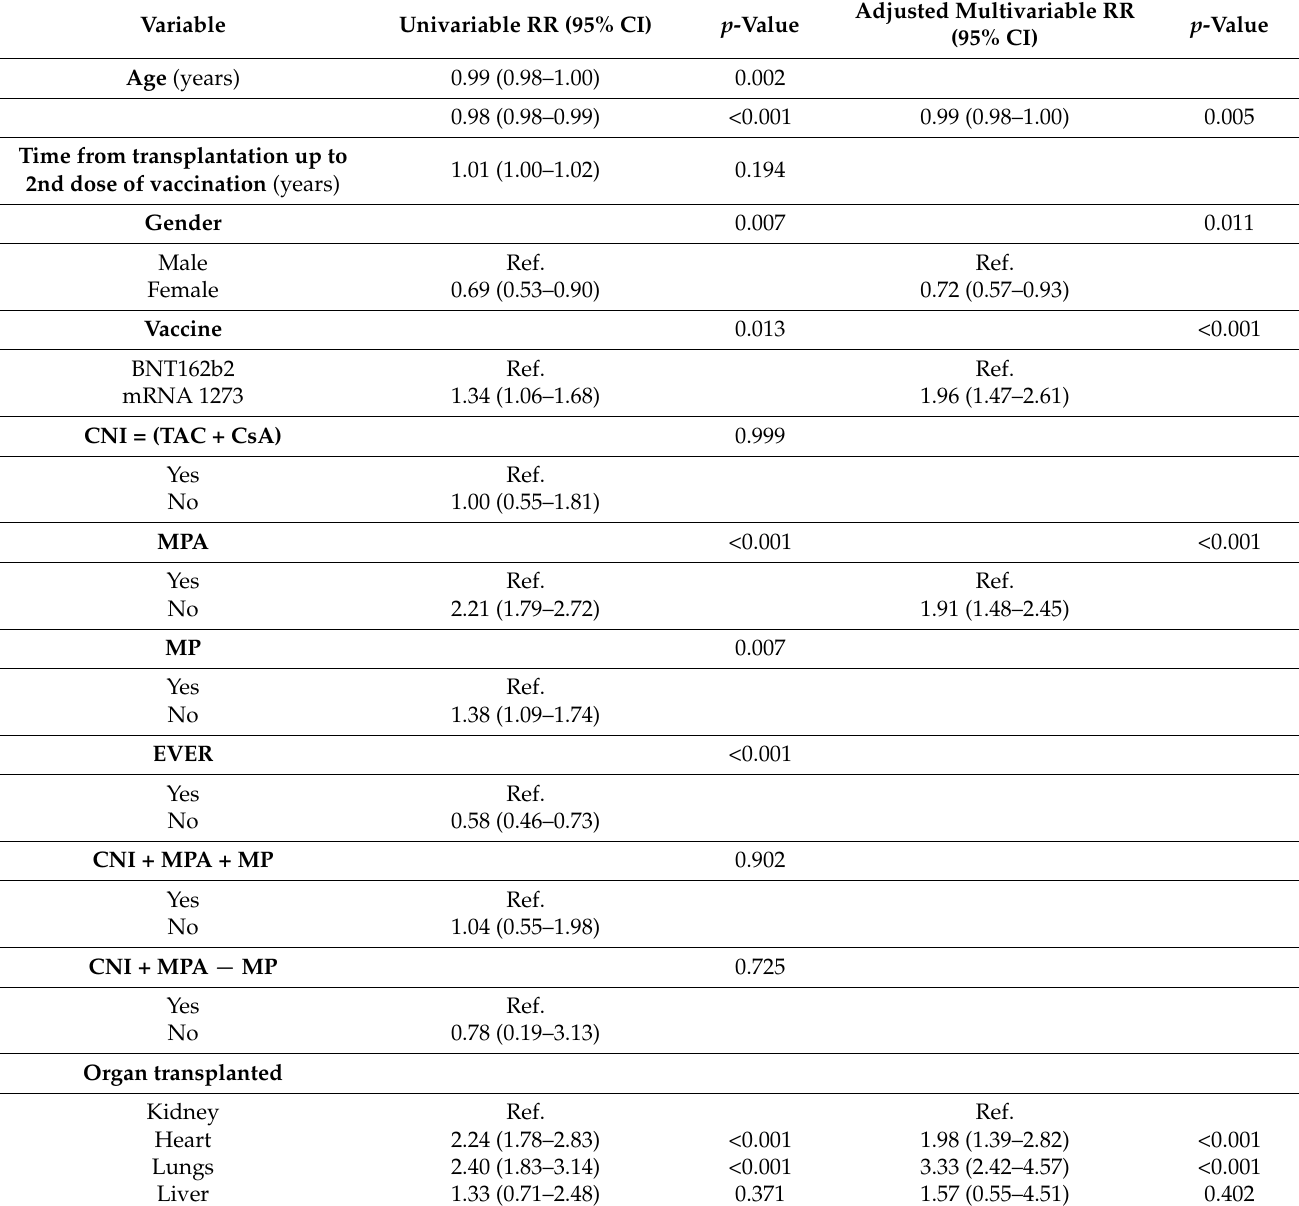
Table 3. Factors associated with the incidence of positive anti-RBD among solid organ transplant recipients in Greece, N = 449 1